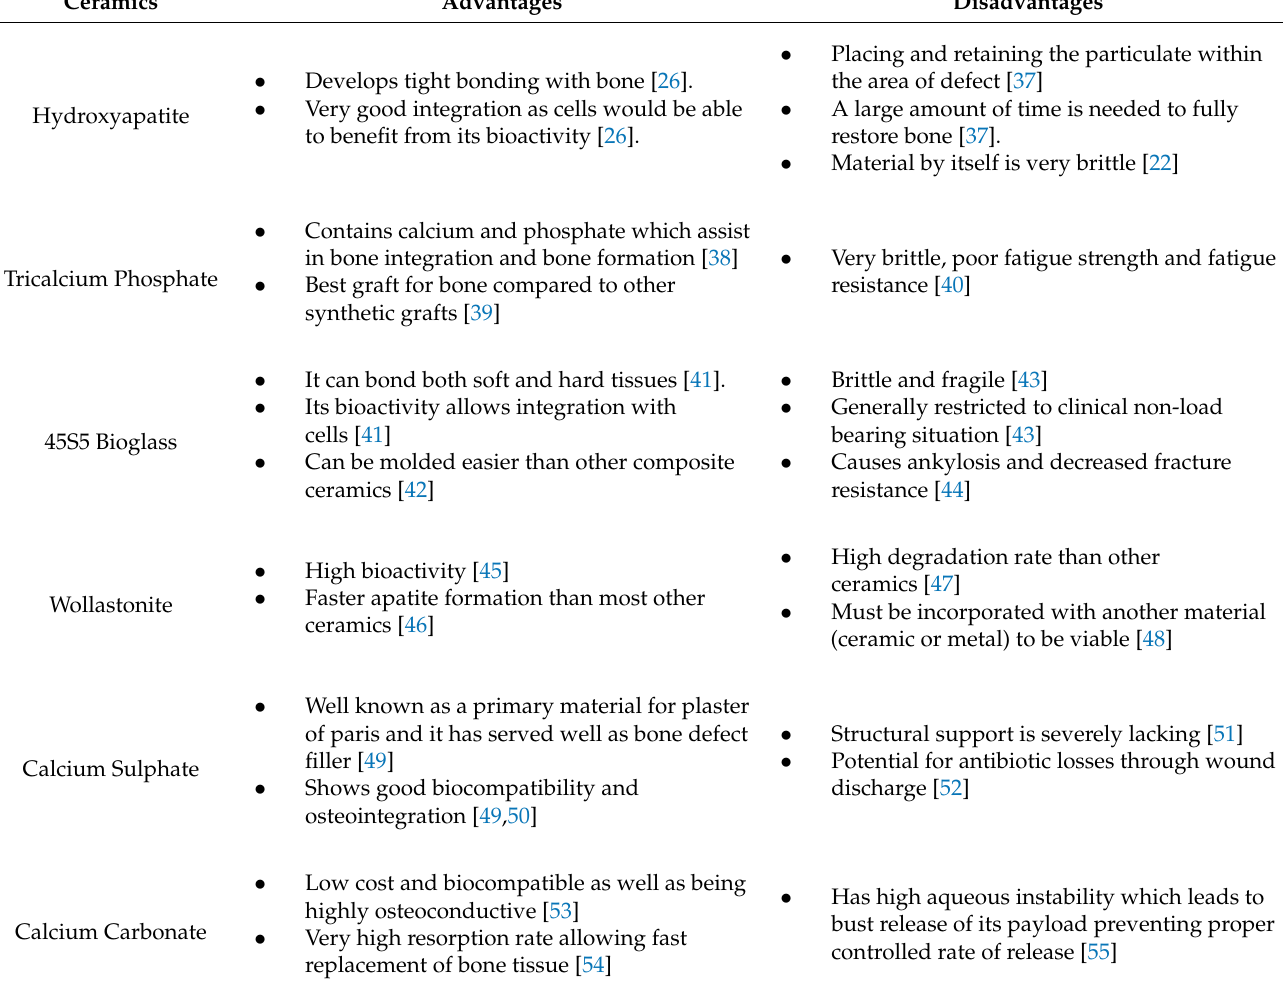
Table 2. Characteristics and Limitations of Current Ceramic